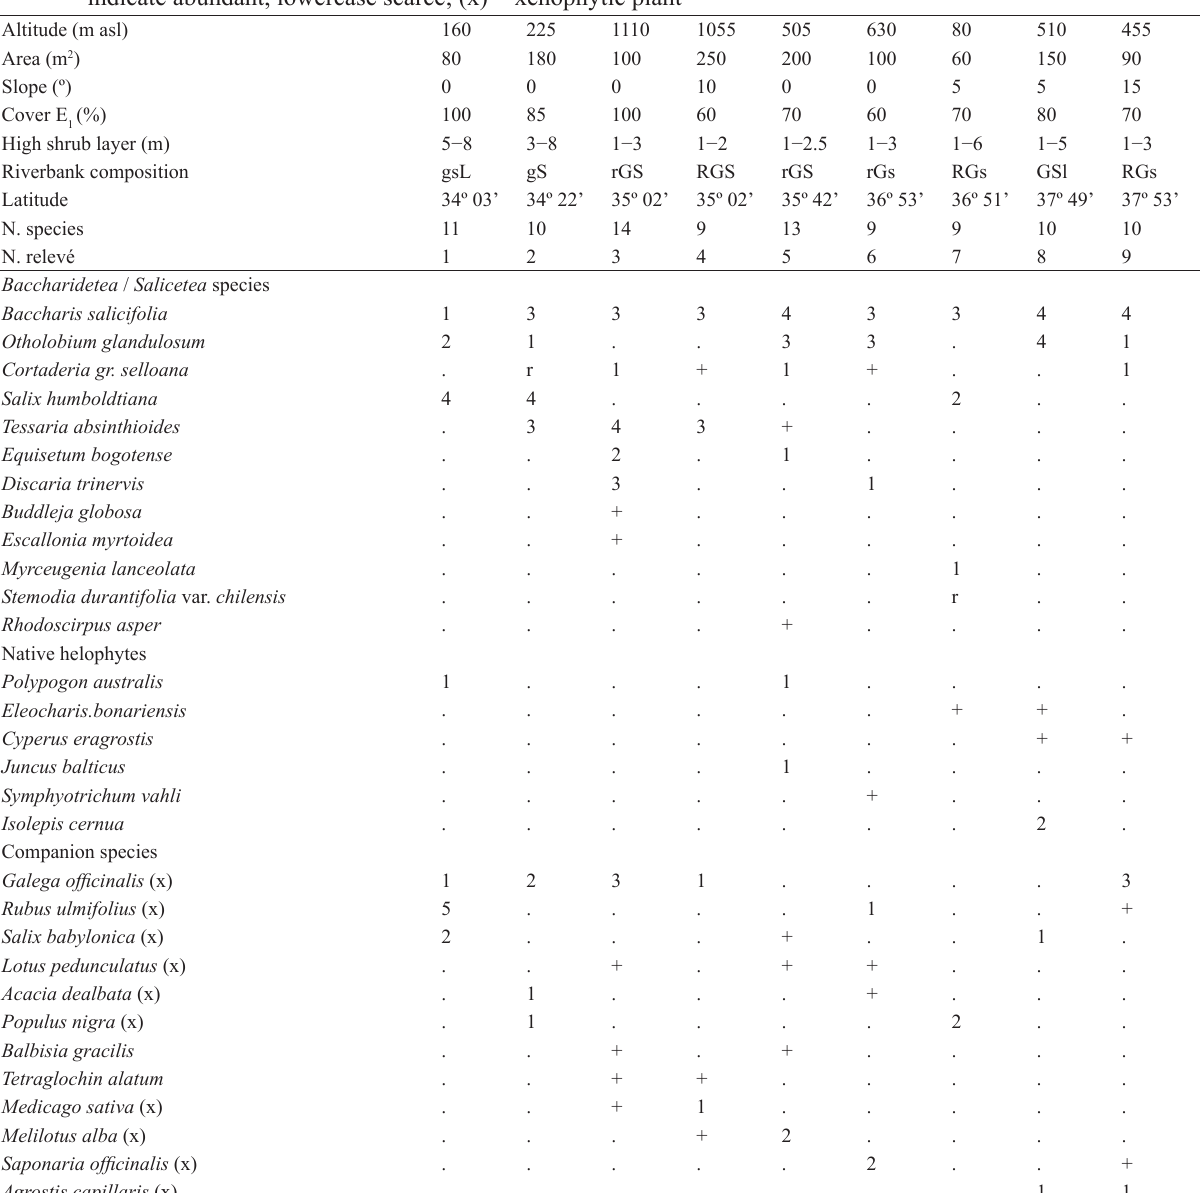
Table 2. Tessario absinthioidis-Baccharidetum marginalis Oberd. 1960 Riverbank composition: R/r = rocks (> 50 cm ∅ ); G/g = gravel (< 50 cm ∅ ); S/s = sand; L/l = silt. Capitals indicate abundant, lowercase scarce; (x) = xenophytic